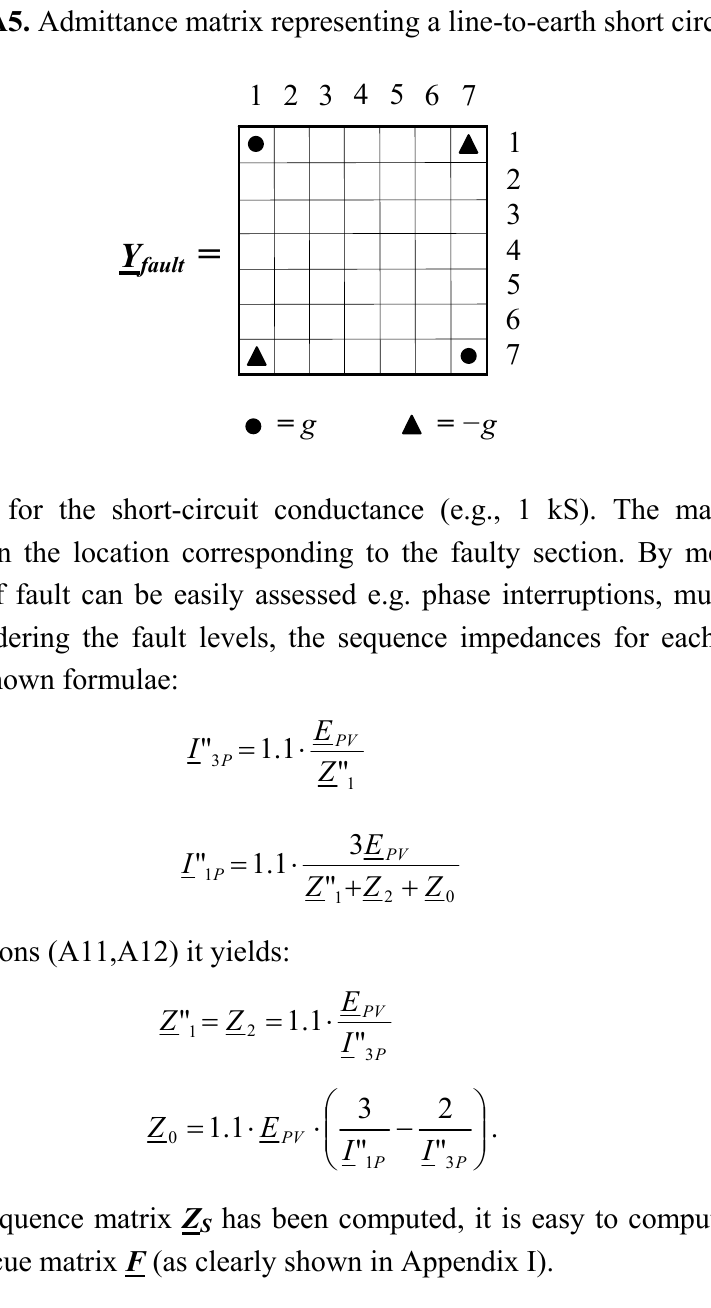
Figure A5. Admittance matrix representing a line-to-earth short